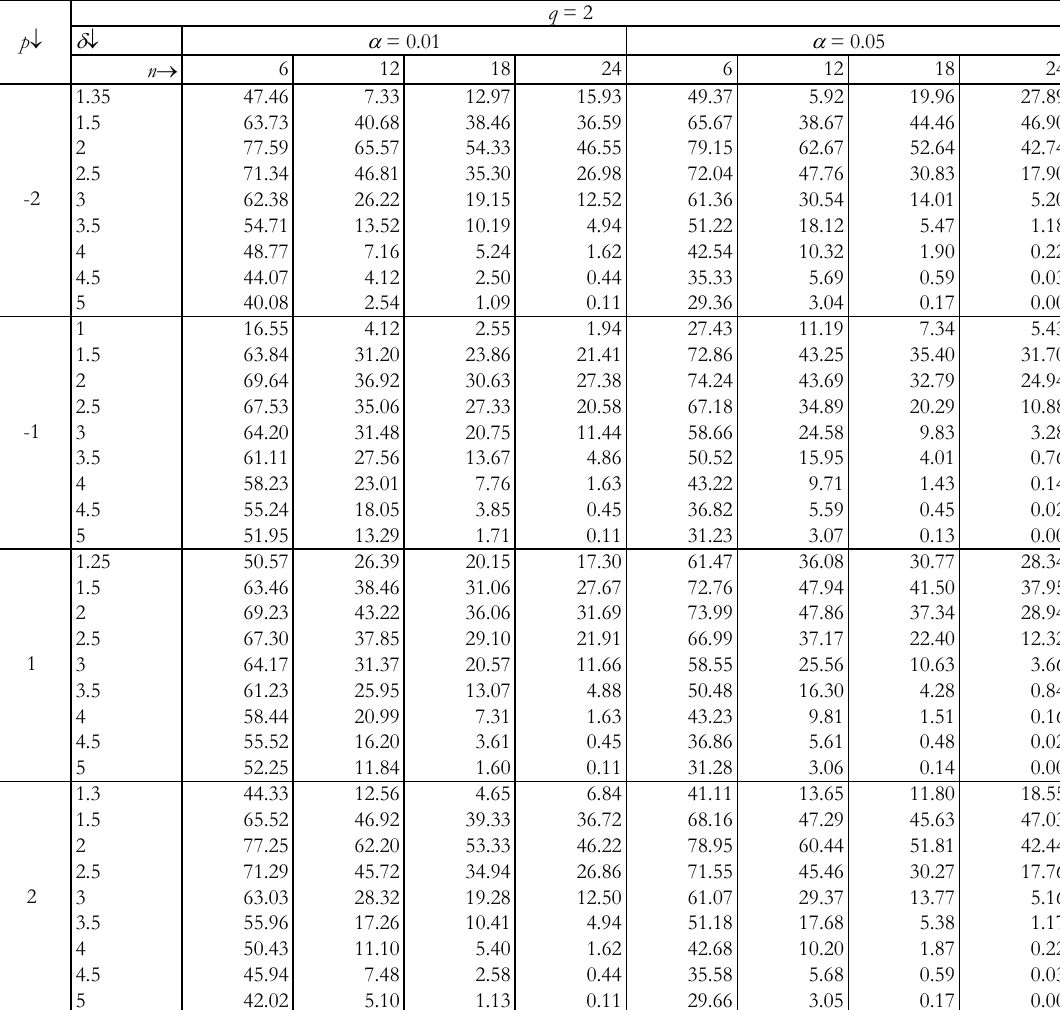
(cid:84) (cid:4) over ˆ (cid:84) (in M ( , ) p q